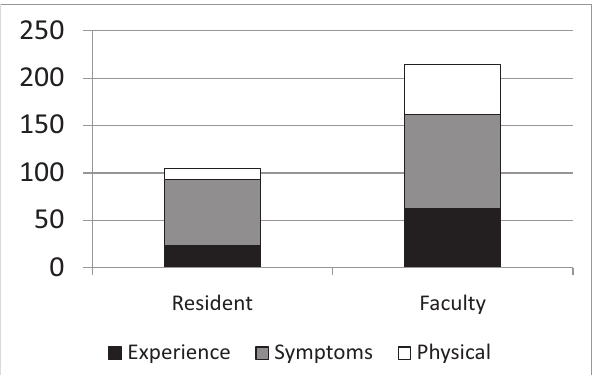
Figure 4. Average number of coded text units per transcript for residents and faculty members that were simultaneously coded as cue generation and experience , symptoms , or physical